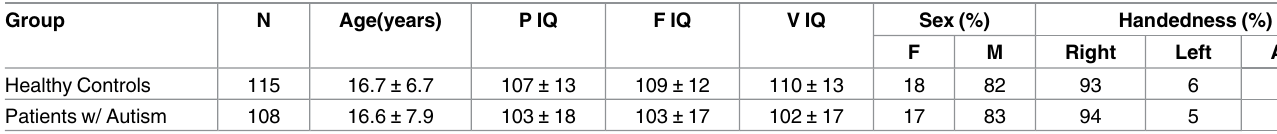
Table 4. Details of Holdout Datasetparticipants,